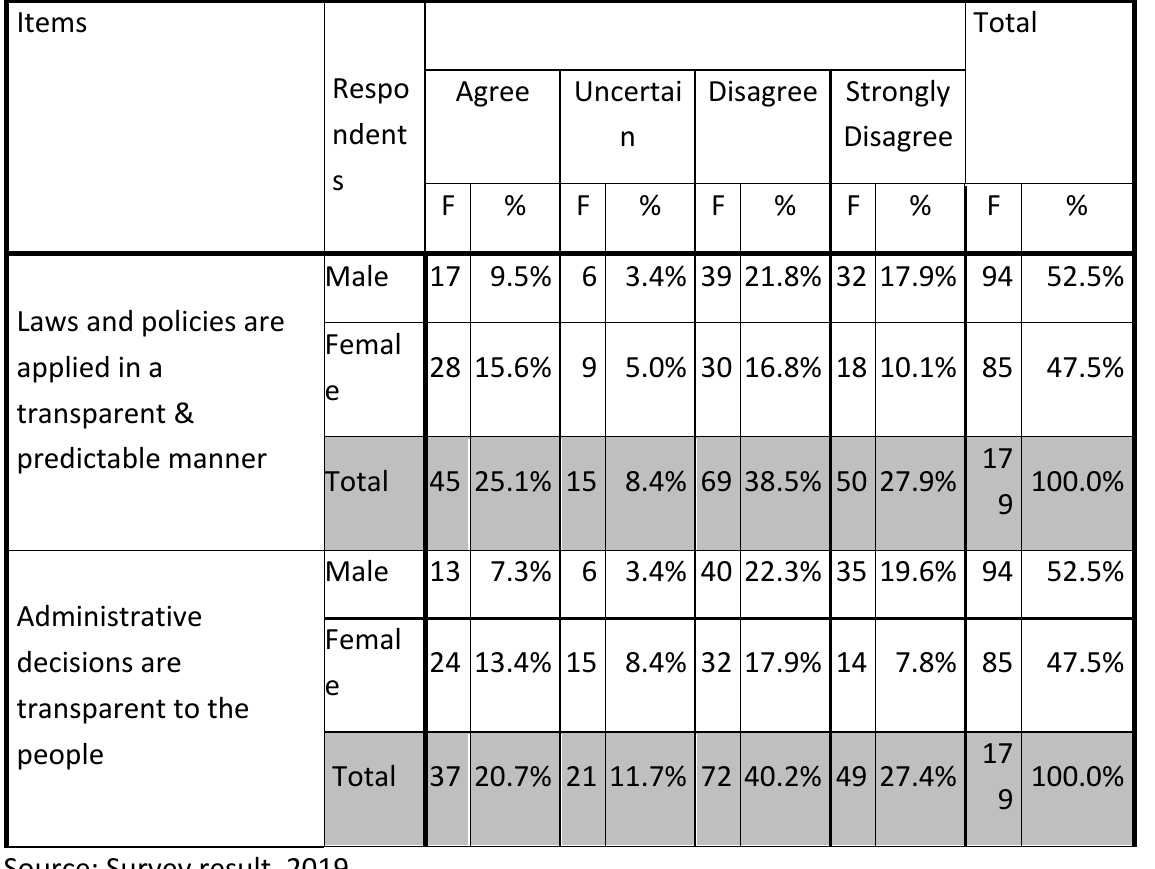
Table 4: Public Views regarding the openness of laws, policies and administrative decisions in BTA